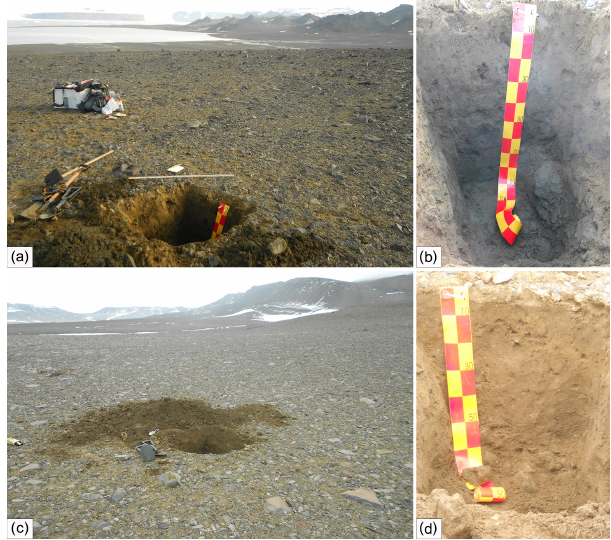
Figure 2. Study sites and soil profiles on James Ross Island; (a) Santa Martha Cove (SMC). It is not covered with vegetation. A 90cm deep soil profile was taken; (b) soil profile Santa Martha Cove (SMC). Scale of the tape measure is in centimeters; (c) study site Brandy Bay (BB) is close to snowfield. It is not covered with vegetation. A 60cm soil profile was taken; (d) soil profile Brandy Bay (BB). Scale of the tape measure is in